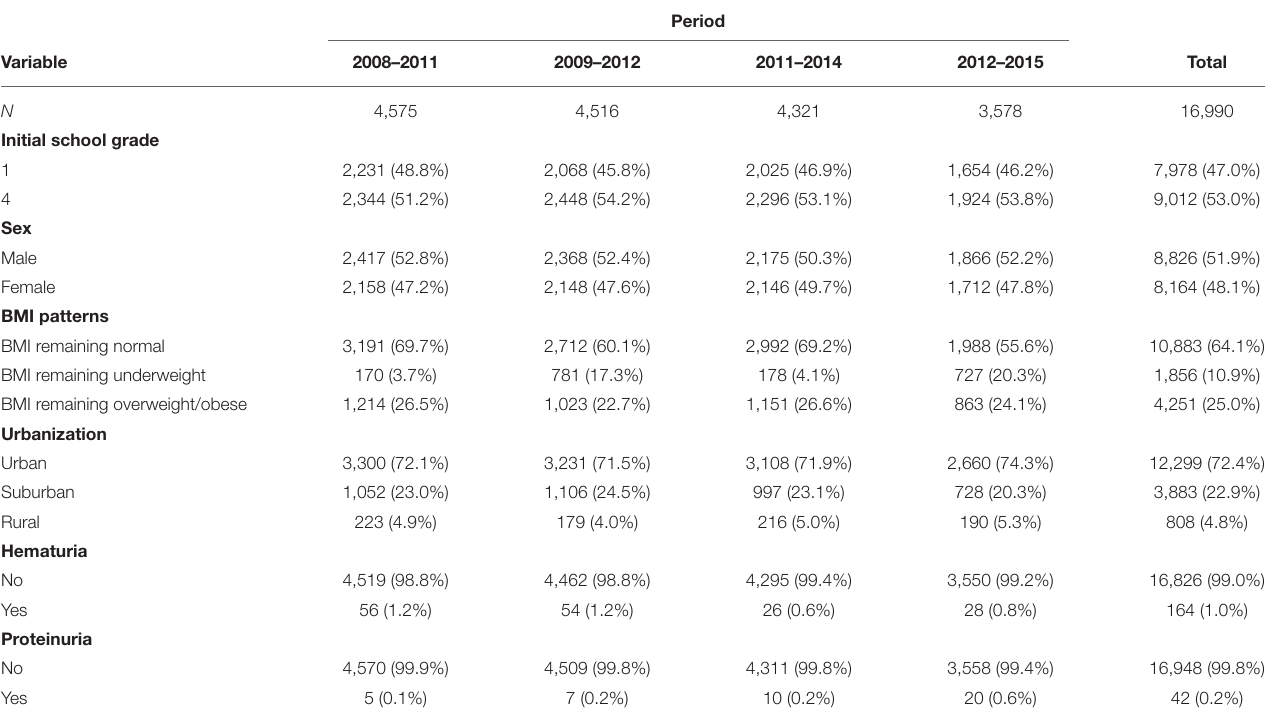
TABLE 1 | Demographic information among students accepting physical examination ( n = 16,990).